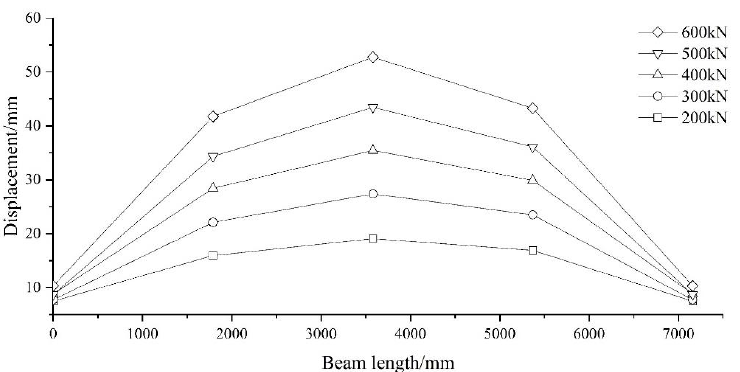
Figure 17. The load-displacement curve measured by dial meters.